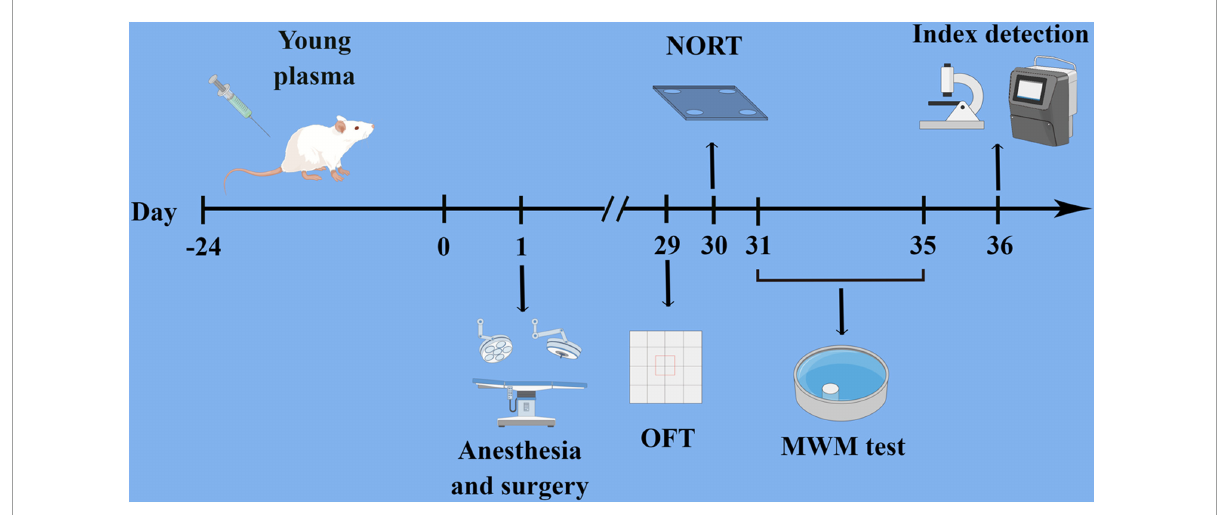
FIGURE1 Experimental flow chart of the study (Drawn by Figdraw platform, ID:UYRPS4e4ff). Rats were treated with a young plasma injection for 24 days, comprising eight pre-infusions, and were subjected to anesthesia and tibial fracture surgery 24 h after the final pre-infusion. After the open field test, novel object recognition test, and Morris water maze test, the rats were sacrificed for a series of